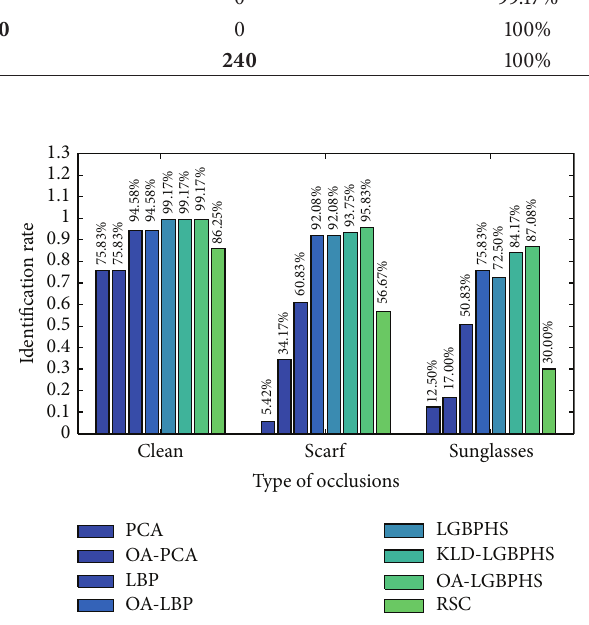
Figure 7: Results of PCA, OA-PCA, LBP, OA-LBP, LGBPHS, KLD- LGBPHS, OA-LGBPHS, and RSC on three different testing sets (faces are clean and faces are occluded by scarf and